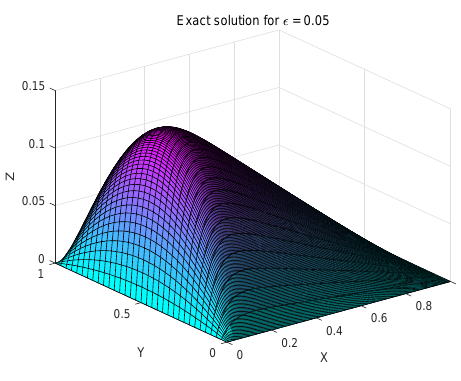
Figure 3. Example 1.